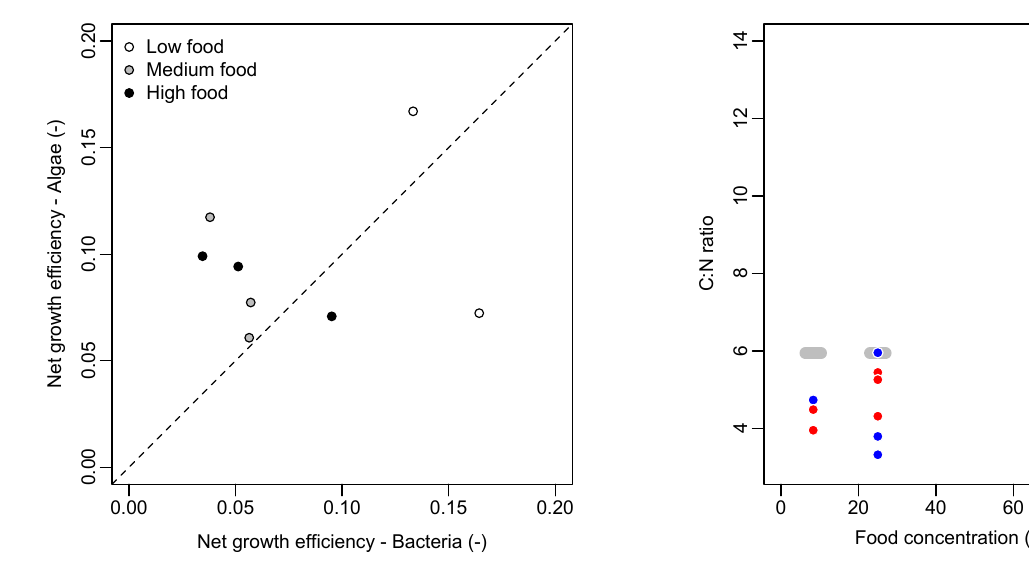
Figure 3. The net growth efficiency of L. pertusa when feeding on algae vs. bacteria. The colours represent the low, medium and high food concentrations, as in Fig. 2.